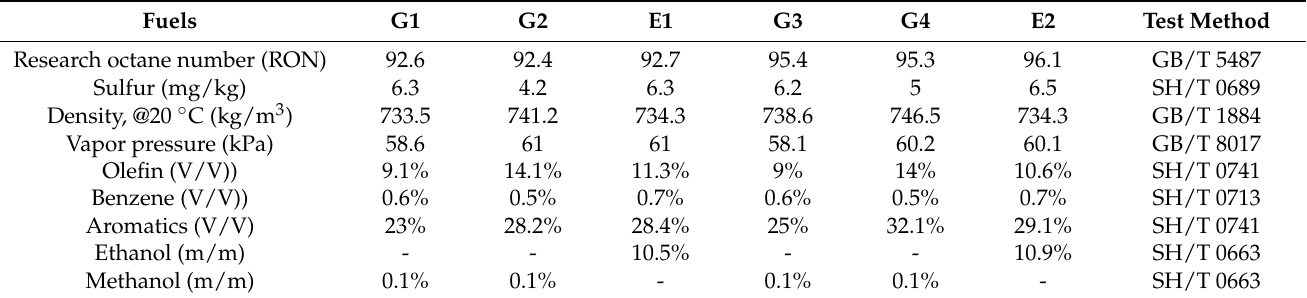
Table 1. Parameters of the tested